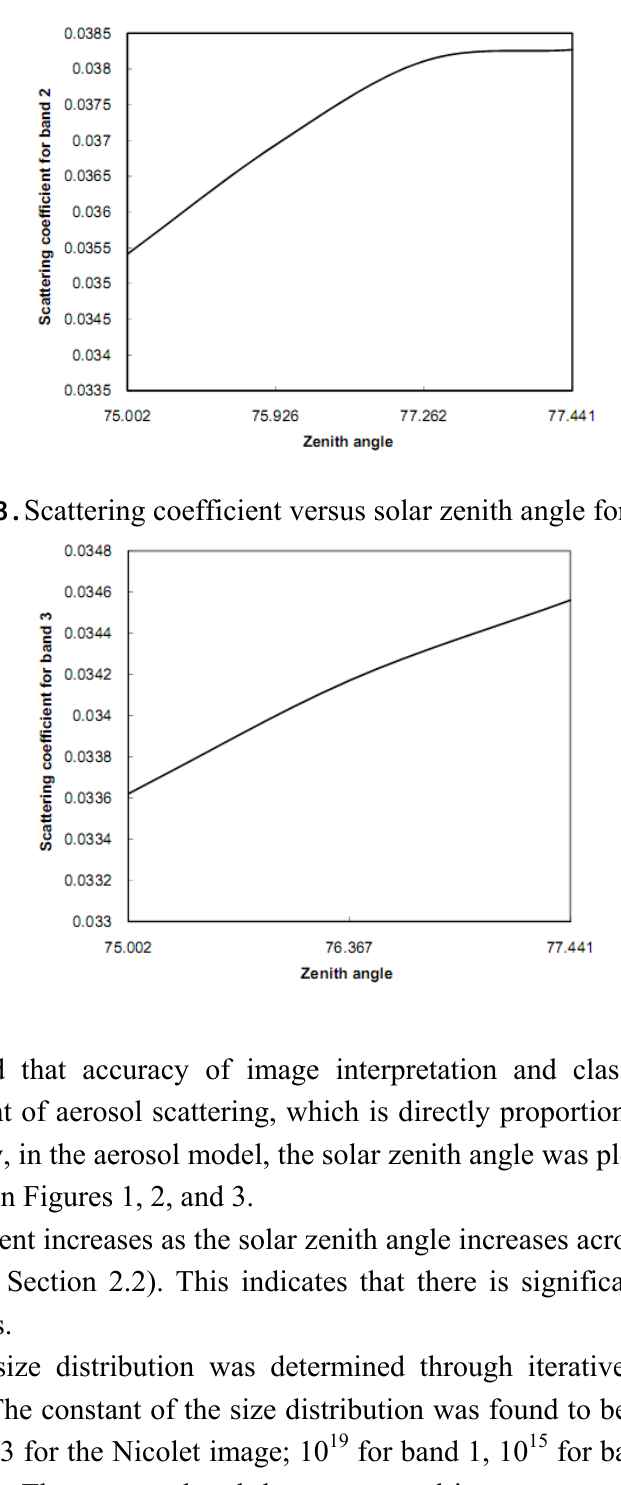
Figure 2. Scattering coefficient versus solar zenith angle for band 2.